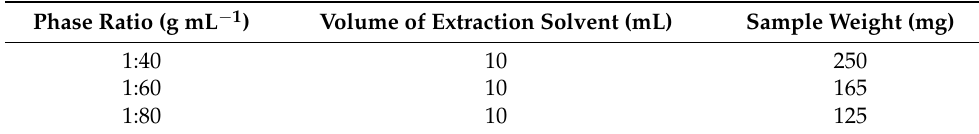
Table 1. Phase ratios, extraction solvent volumes, and sample weights used.